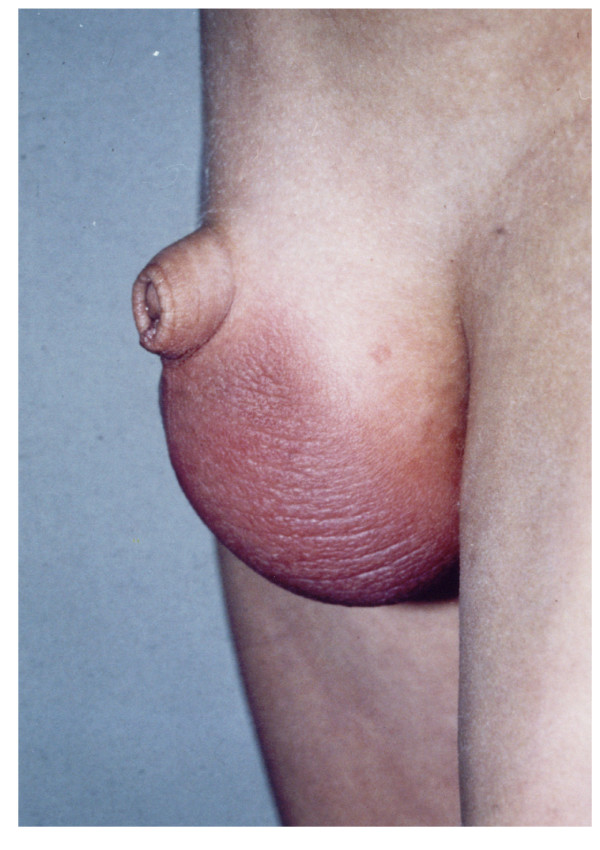
The child's scrotum. Note the redness and fullness of both scrotal compartments.